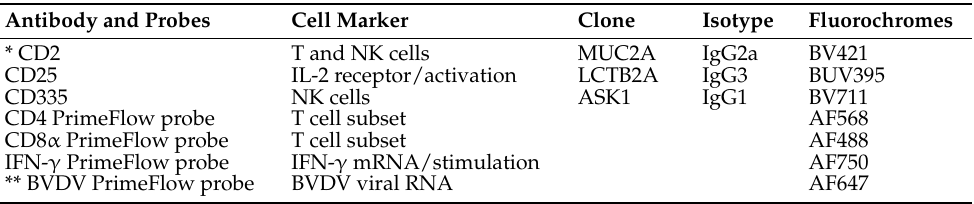
Table 1. Primary and secondary antibodies used for surface marker expression on PBMC’s and Primeflow probes used for cell mediated immune response comparisons. Antibody and